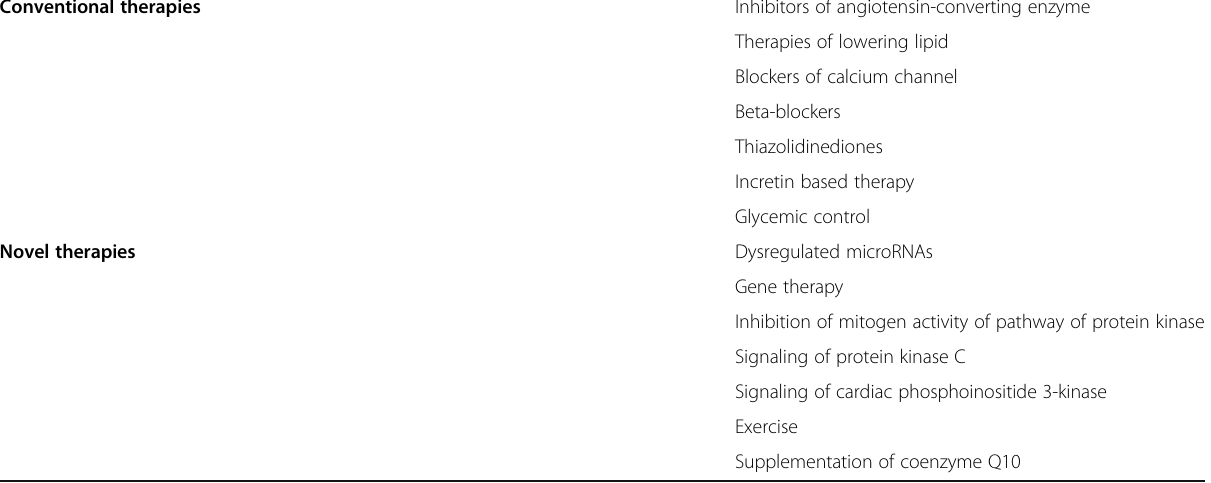
Table 7 Treatment strategies of diabetic cardiomyopathy Conventional